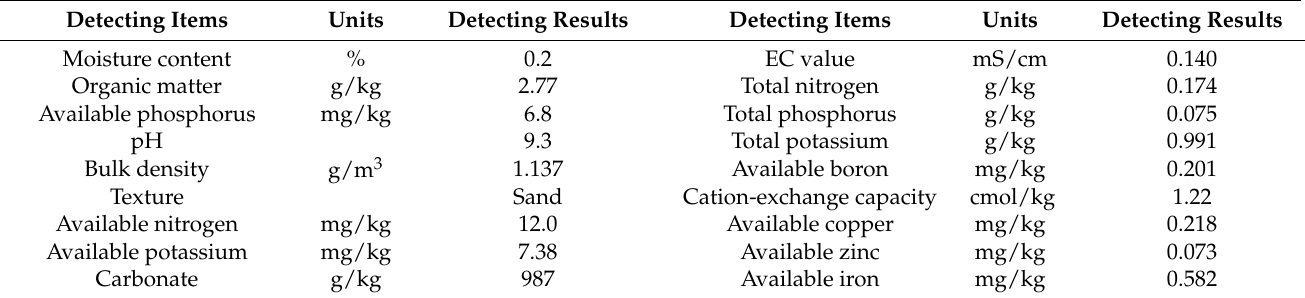
Figure 2. Particle-size distributions of ( a ) cement, ( b ) silica fume aggregate, and ( c ) CCCW. Table 3. Detected material properties of the coral